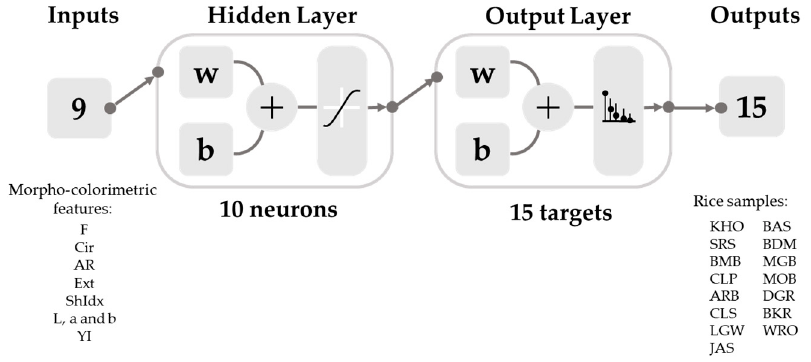
Figure 5. Diagram of a neural network model (Model 2) of the Bayesian Regularization algorithm with seven hidden neurons and sigmoid function showing nine inputs of morpho-colorimetric parameters and 15 outputs of commercial rice grains. The abbreviation for morpho-colorimetric parameters (inputs) and commercial rice grains (outputs) are shown in Tables 1 and 2. w = weight; b = bias.